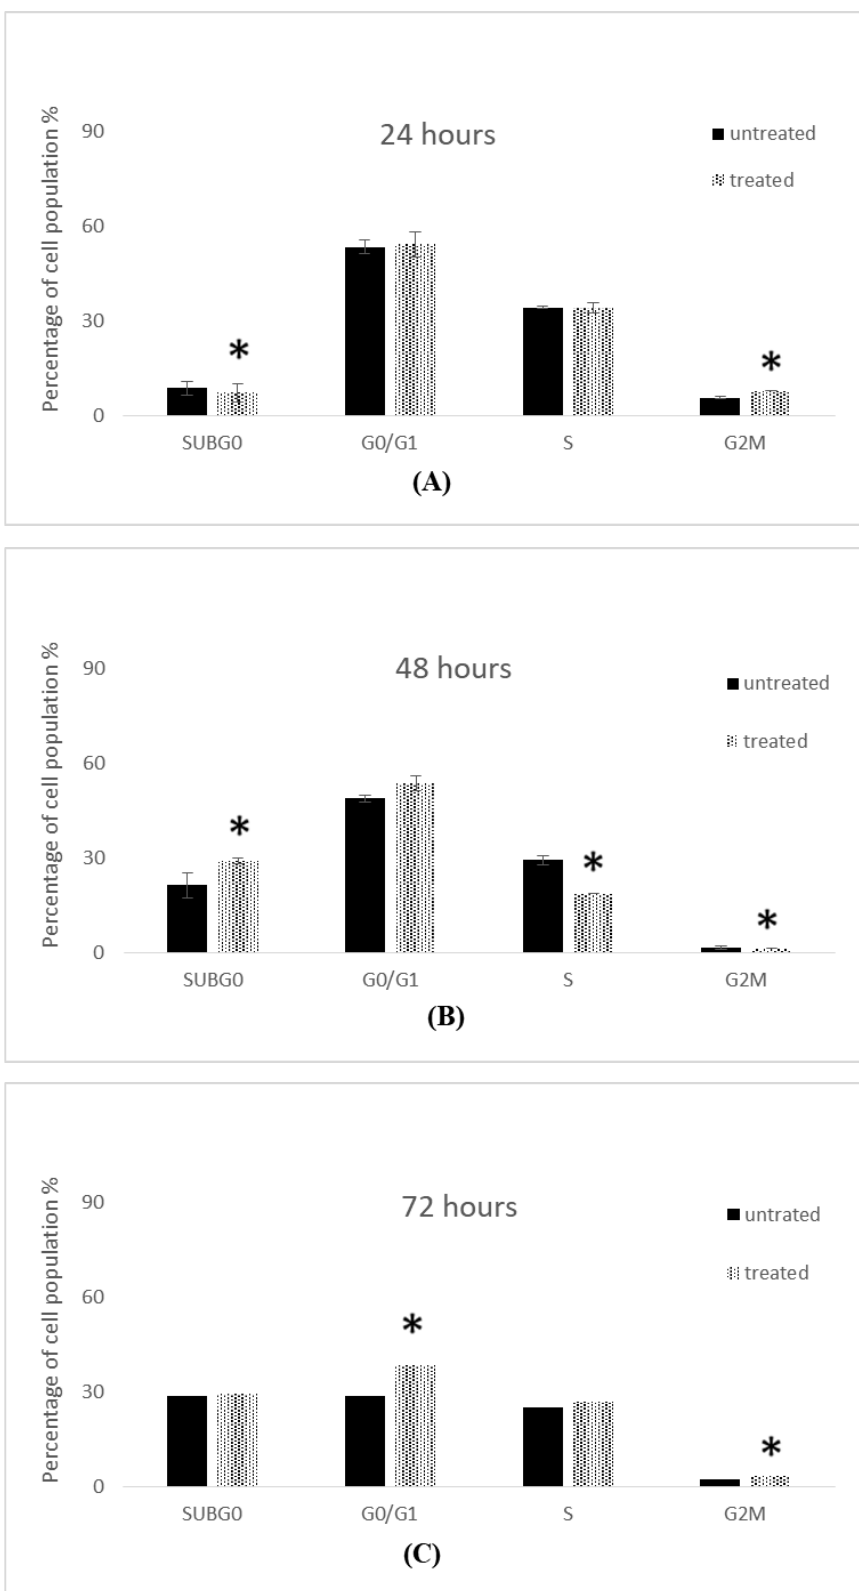
Figure 20. Cell cycle profile of MCF-7 cells treated with 7-geranylcinnamic acid. Each data point represents the mean of three independent experiments ± SD. * Significantly different from the control ( p < 0.05). ( A ) 24 h, ( B ) 48 h and ( C ) 72 h of